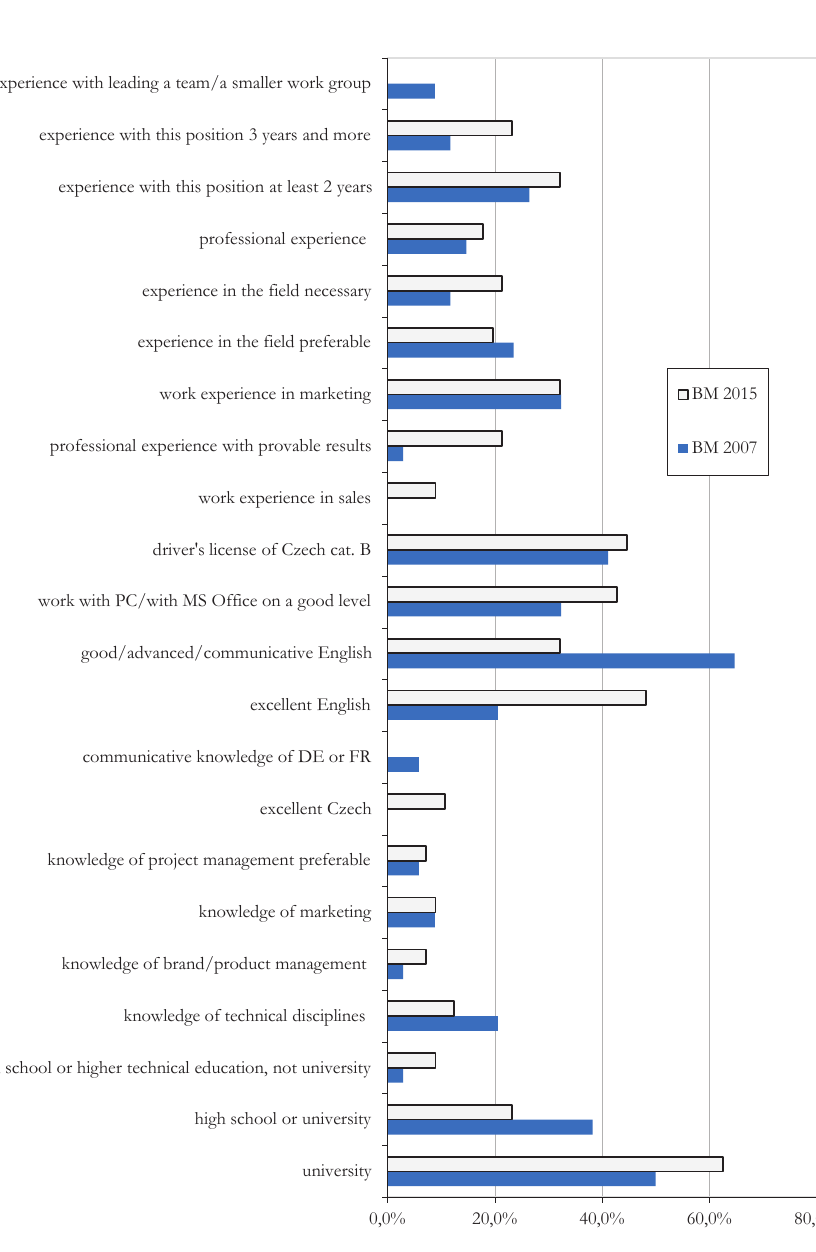
Fig. 1 - Comparison of relative frequency of hard skills applied for a brand manager by advertisers in 2007 and 2015. Source: Independent